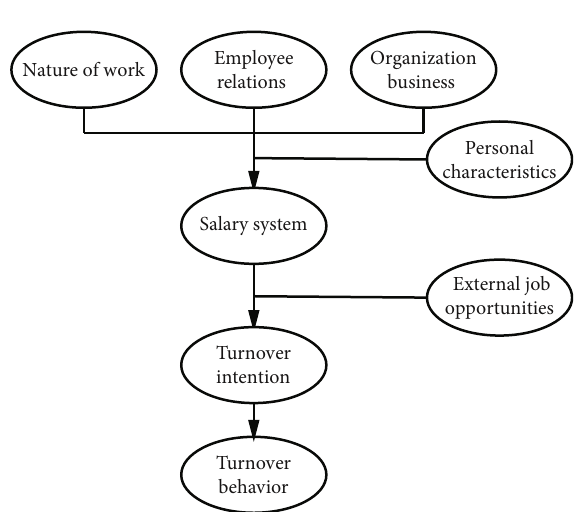
Figure 1: Szilagyi turnover process